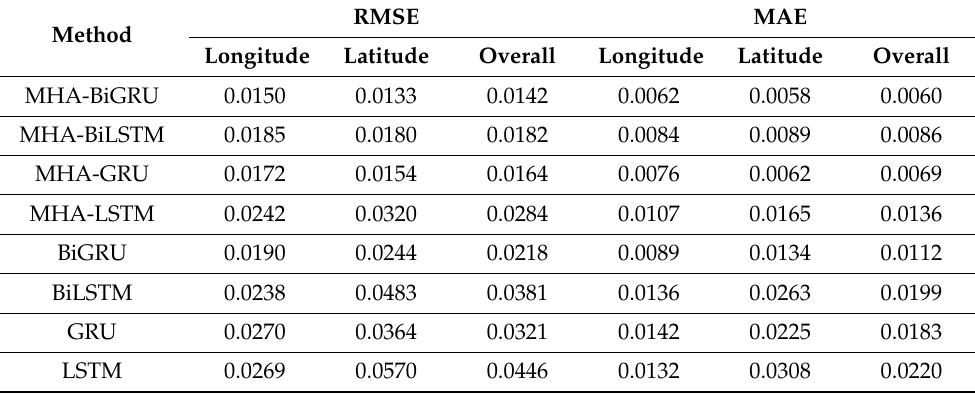
Table 2. RMSE and MAE value comparison among all